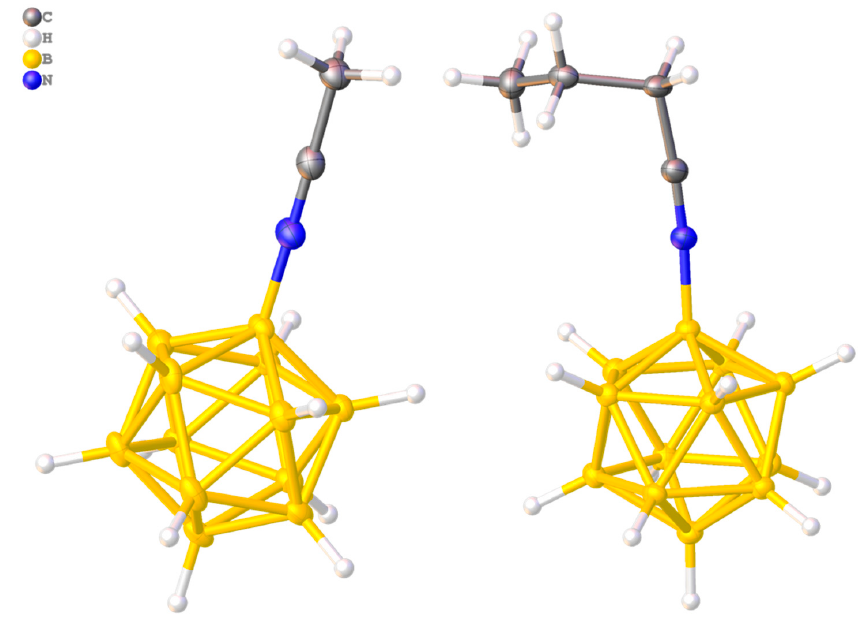
Figure 1. Structures of [B 12 H 11 NCCH 3 ] − and [B 12 H 11 NCC 3 H 7 ] − . In the crystal structure of compound 1a , cation-anion layers of [B 12 H 11 NCCH 3 ] − ani- ons and (C 2 H 5 ) 4 N + cations were formed, parallel to the plane ab (Figure 2a). The anions bound to each other in dimeric pairs by weak CH...HB(B) contacts were located sequen- tially above each other along the a-axis. The cations and anions were also connected by a network of weak CH...HB(B) interactions, which are shown as red spots on the Hirschfeld surface of the anion (Figure 2b). H...H contacts accounted for 92.5% of the anion surface, while H...C/C...H and H...N/N...H contacts accounted for 5.5% and 2.0% of the anion sur- face, respectively.